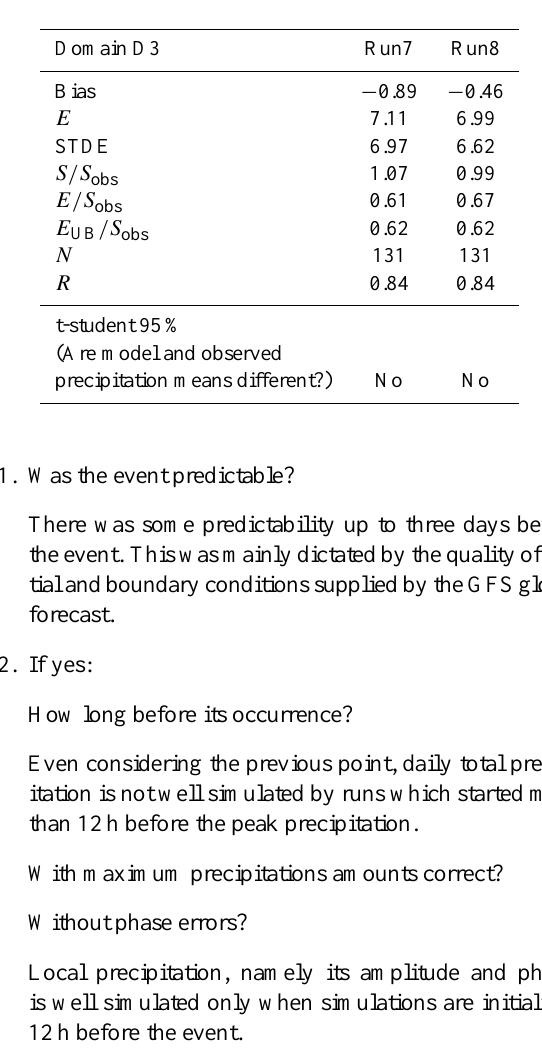
Table 4. Error Analysis over domain D3 ( R is the spatial correlation between simulated and observed